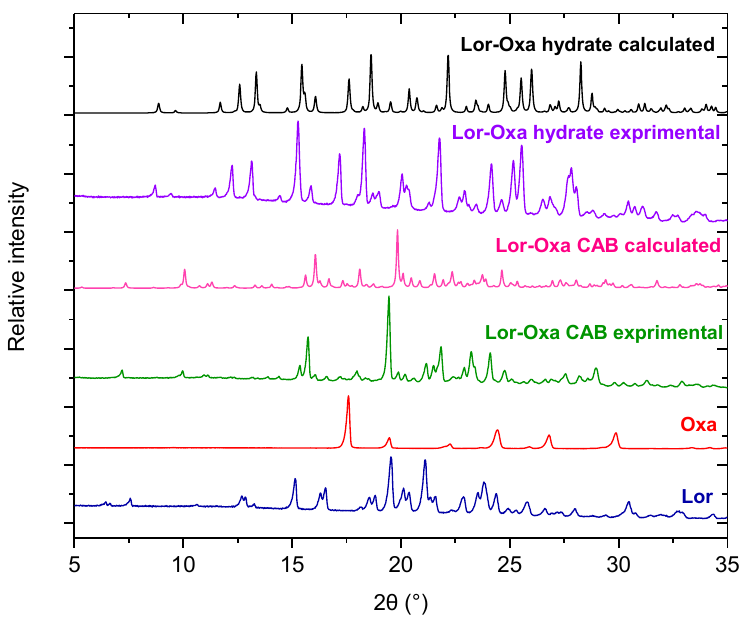
Figure 1. Experimental powder X-ray diffraction (PXRD) patterns of Lor, Oxa, Lor-Oxa conjugate acid-base salt (CAB), Lor-Oxa hydrate, and calculated PXRD patterns of Lor-Oxa CAB, and Lor-Oxa hydrate .